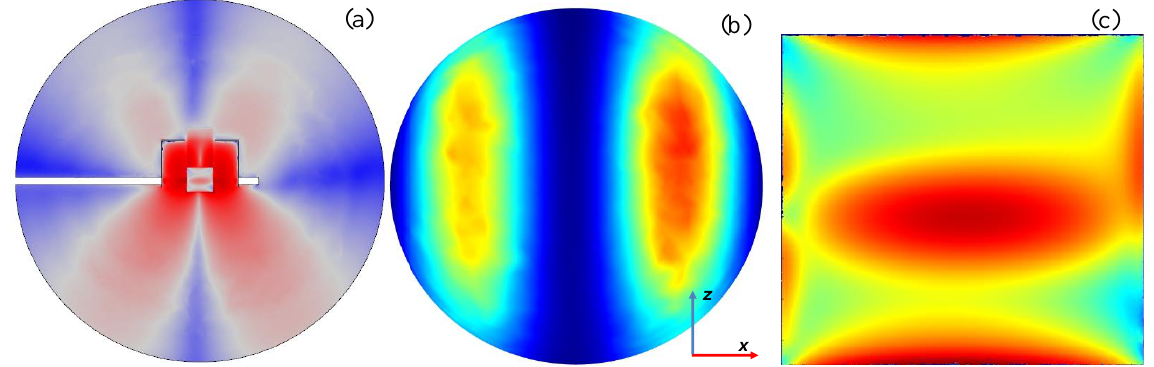
Figure 12. ( a ) Distributions of the log 10 of | E |/(1 V/m); ( b ) distributions of the power flux W /(1 W/m 2 ) on the lower part of the radiation sphere; and ( c ) distributions of the log 10 of Q rh /(1 Wm −3 ). Details in ( a ), ( b ), and ( c ) are the same as in Figures 7–9, respectively. P ent = 100 W and L = 35 mm.